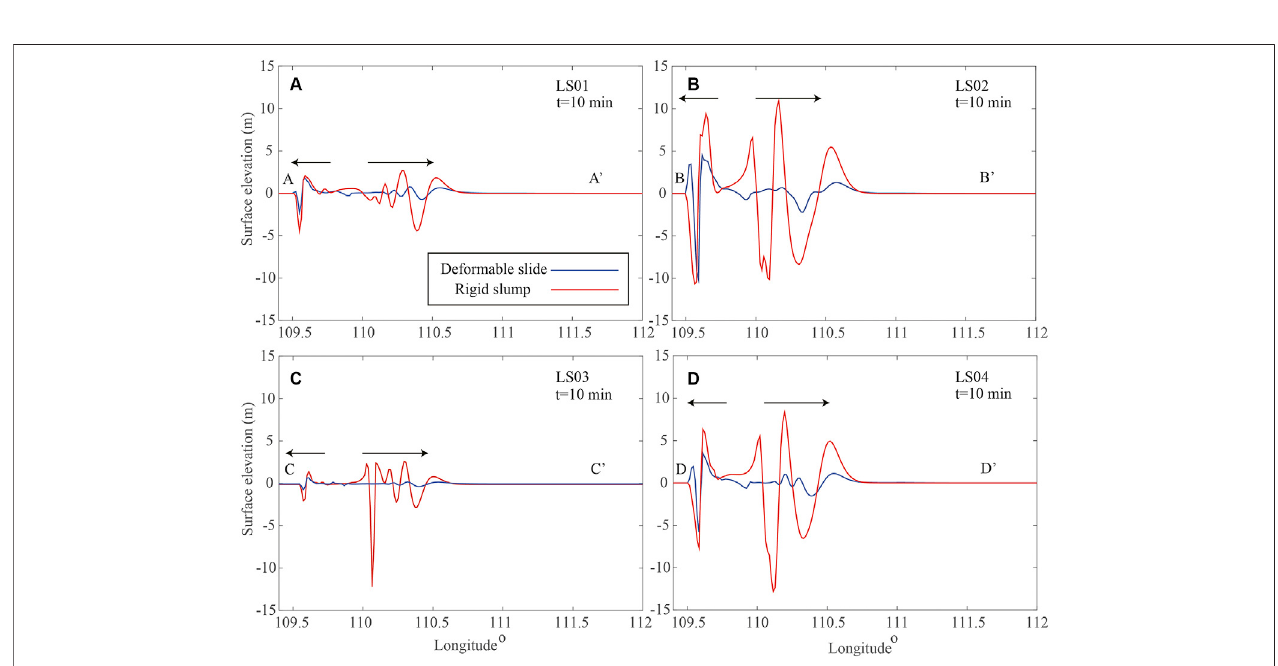
FIGURE4| Thepro fi lesoftsunamisurfaceelevationgeneratedby (A) LS01, (B) LS02, (C) LS03, (D) LS04alongtransects AA 9 – DD 9 at t =10 min.Seelocationsof AA 9 – DD 9 in Figure 3 .